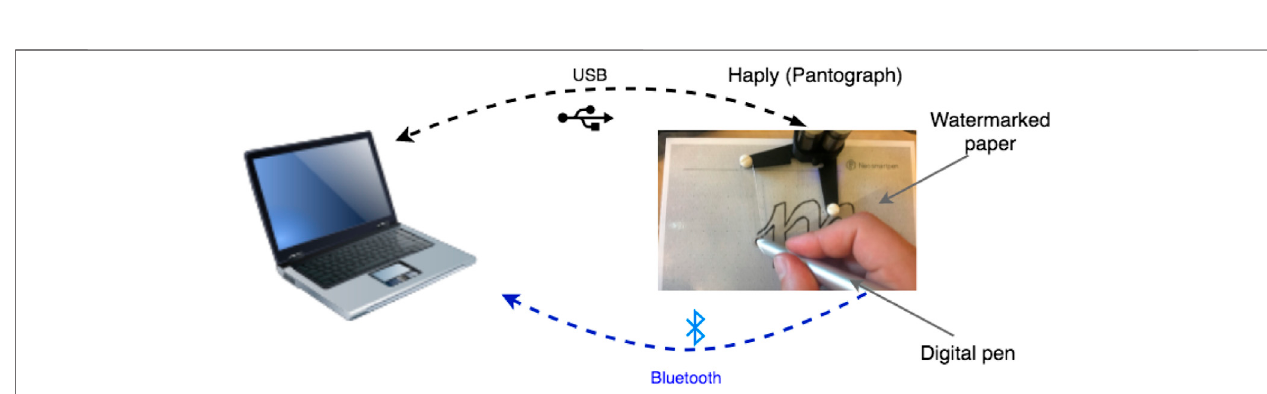
FIGURE3| TechnicalSetup.OurdemonstrationplatformconsistsofaHaplyforce-feedbackpantograph,aUSB-connecteddigitalpen,andahostcomputer.The Haply communicates position information to the host computer and receives motor commands through a USB port. A digital pen captures and conveys thes user ’ s stroke, along with data opressure, twist, tilt and